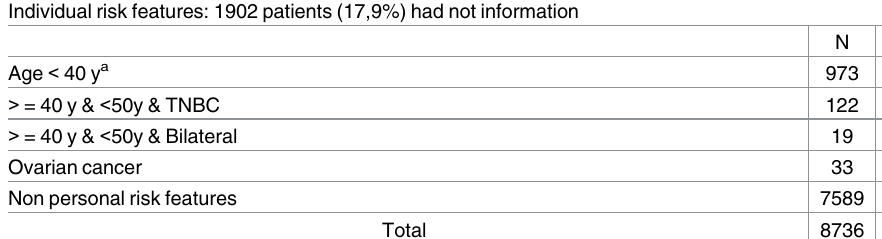
Table 1. Individual and familial features distribution in the global sample. Individual risk features: 1902 patients (17,9%) had not information